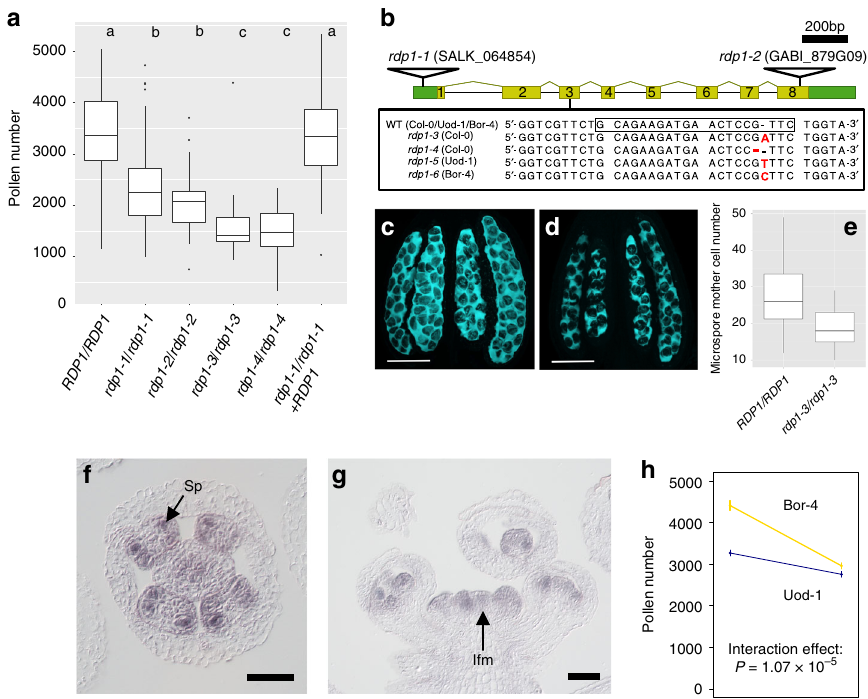
Fig. 2 Functional characterization of the RDP1 gene. a Pollen number differences between four homozygous mutants ( rdp1-1/rdp1-1 , rdp1-2/rdp1-2 , rdp1-3/ rdp1-3 , and rdp1-4/rdp1-4 ), wild-type ( RDP1/RDP1 ), and the complemented lines ( rdp1-1 / rdp1-1 + RDP1 ). Letters a, b, c indicate signi fi cant differences, determined by nested analysis of variance (ANOVA) and post hoc Tukey test; P < 0.05 (See Supplementary Table 8 for P values). Numbers of fl owers pollen-counted (left to right, as plotted): N = 132, 45, 40, 60, 135, 411. b Schematic structure of the RDP1 gene. Untranslated regions (green boxes), coding regions (yellow boxes), introns (bars), two T-DNA insertion mutants ( rdp1-1 , rdp1-2 ; open triangles), and four CRISPR/Cas9-based frameshift mutants ( rdp1-3 and rdp1-4 in Col-0, rdp1-5 in Uod-1, and rdp1-6 in Bor-4 backgrounds, respectively). The box in the wild-type sequences indicates the target site for CRISPR/Cas9, and red letters in mutants show the indel mutation. c , d Representative microsporocyte images of RDP1/RDP1 ( c ) and rdp1-3/rdp1-3 ( d ) stained with aniline blue. Dark spots indicate microsporocytes. Summary of observation is depicted in e . e The number of microsporocytes was signi fi cantly lower in rdp1-3/rdp1-3 than in the wild type (Wilcoxon rank sum test, P = 2.82e – 06). Numbers of anthers counted (left to right, as plotted): N = 40 and 50. f , g In situ hybridization for RDP1 . Similar expression patterns were observed in four ( f ) and two ( g ) individuals. f Stage 8 fl oral cross section; expression is detected in sporogenous cells (Sp). g In fl orescence longitudinal section; expression is observed in the in fl orescence meristem (Ifm) and young fl owers. h Pollen number of wild type and null mutants in the Uod-1 (blue) and Bor-4 (yellow) accessions. Dots and error bars indicate means and standard errors of means, respectively. The mutation in Bor-4 caused a stronger reduction in pollen number than that in Uod-1 (ANOVA interaction effect P = 1.07 × 10 – 5 , one-sided test). Boxplots a , e show center line: median; box limits: upper and lower quartiles; whiskers: not >1.5 times the interquartile range; dots: outliers. Scale bars: 50 μ m. Source data underlying a , e and h are provided as a Source Data fi